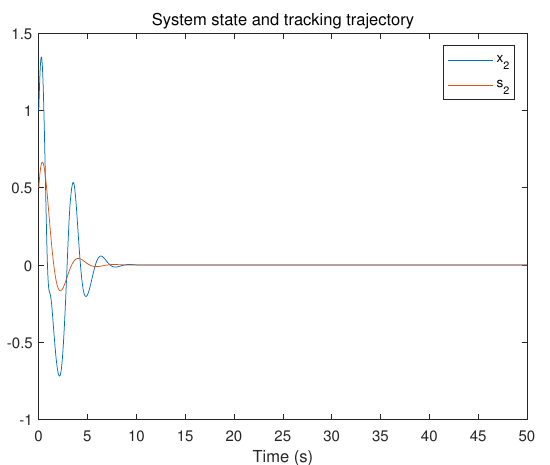
Figure 1. System state x 1 and its tracking trajectory when η 1 = 1 and η 2 = − 1.